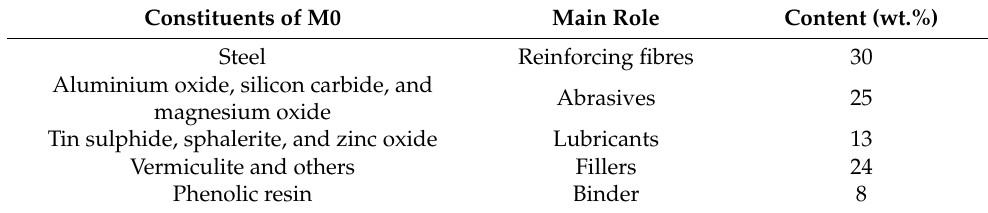
Table 1. Main components of M0, their roles, and estimated contents in the reference masterbatch without graphite.